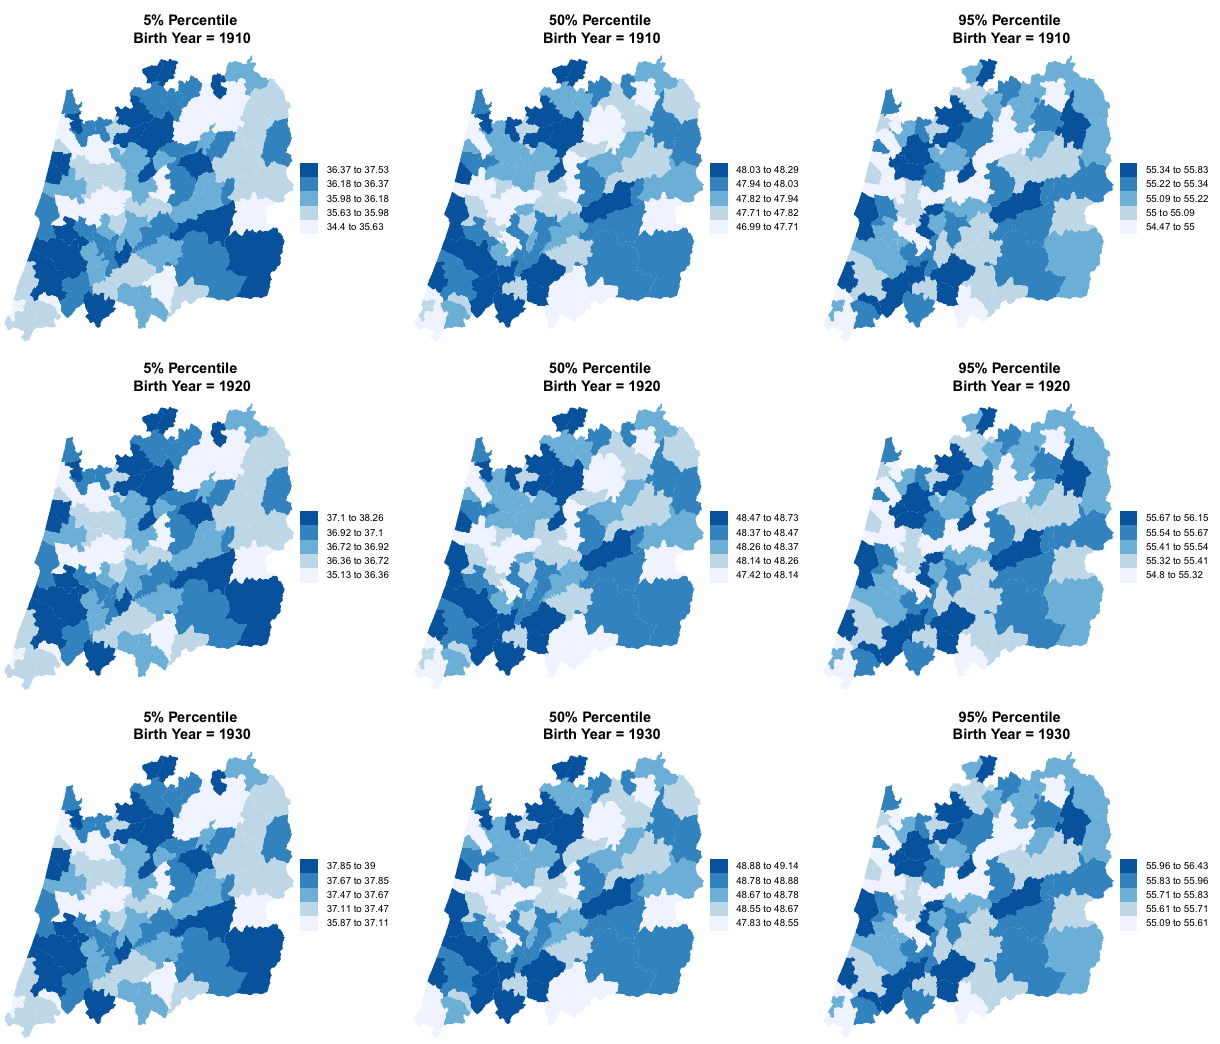
Figure 3. Estimated AaM by region and birth year. Percentiles 5%, 50% and 95% for the central region of Portugal for the years 1910, 1920 and